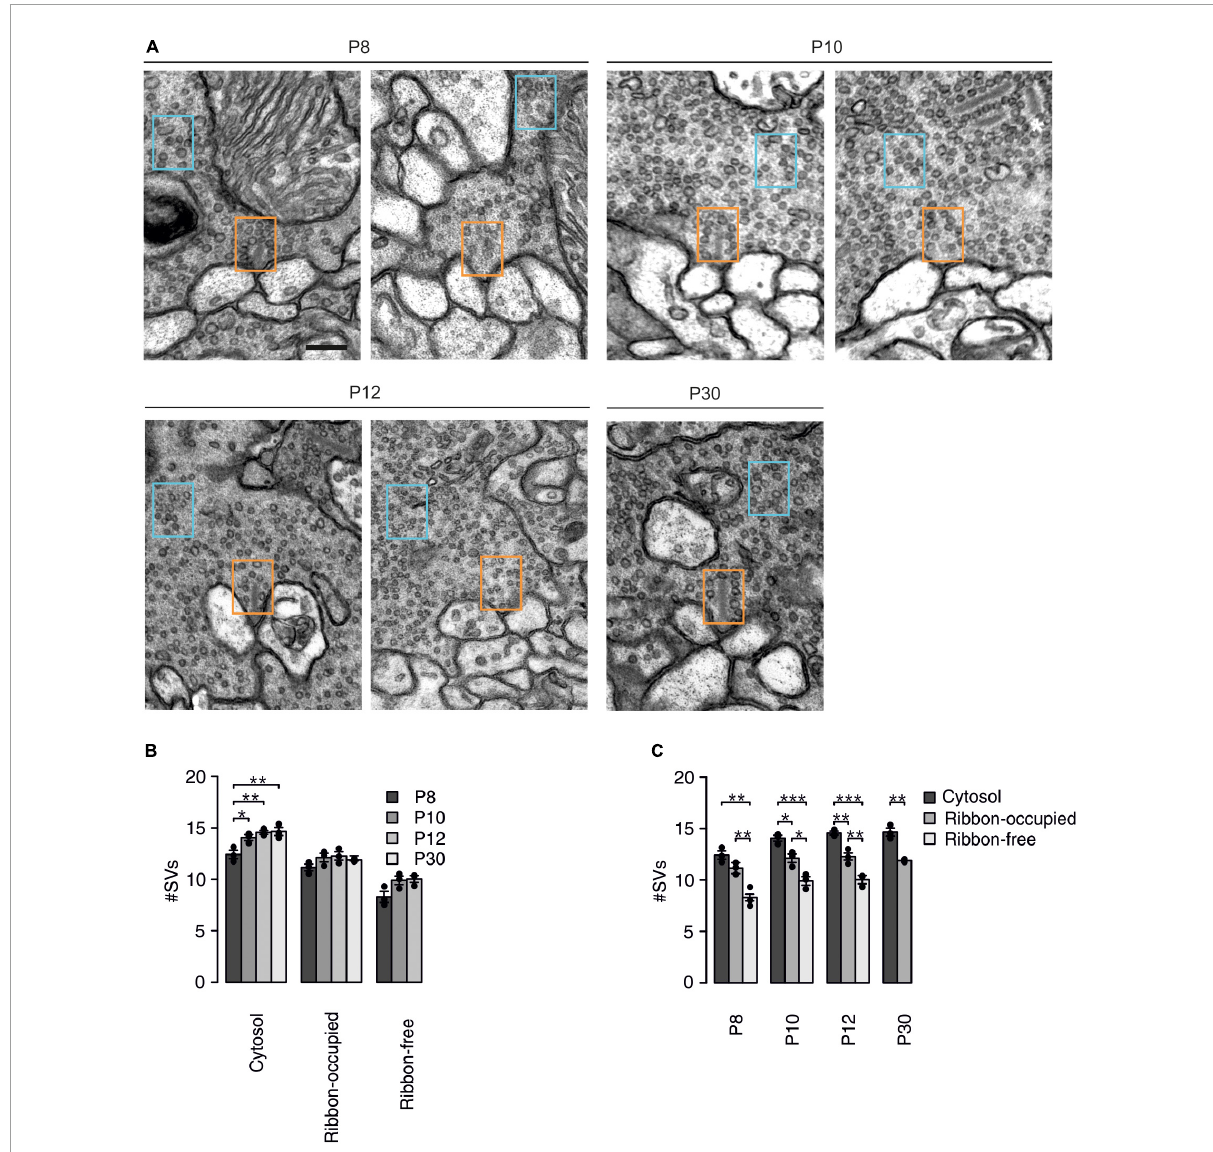
FIGURE4 Postnatal changes in SV density in cone photoreceptors synaptic terminals. (A) Representative electron micrographs of ribbon-occupied (left) and ribbon-free (right) AZs at mouse cone photoreceptor terminals at the different developmental stages. Number of SVs was quantified in a 300 × 200 nm region in the cytosol (blue box) and at an empty or ribbon-occupied AZ (orange box). Scale bar: 200 nm. (B) Number of SVs in a 300 × 200 nm region in different synaptic regions at the different developmental stages ( p < 0.001, n = 3 mice, two-way ANOVA). Post hoc pairwise Tukey tests of the cytosol group (P8 vs. P10: p = 0.033, P8 vs. P12: p = 0.008, P8 vs. P30: p = 0.006, P10 vs. P12: p = 0.718, P10 vs. P30: P = 0.603, P12 vs. P30: p = 0.997), ribbon-occupied AZ (P8 vs. P10: p = 0.258, P8 vs. P12: p = 0.164, P8 vs. P30: p = 0.457, P10 vs. P12: p = 0.986, P10 vs. P30: p = 0.963, P12 vs. P30: p = 0.848) and ribbon-free AZ (P8 vs. P10: p = 0.089, P8 vs. P12: p = 0.069, P10 vs. P12: p = 0.977). (C) Number of SVs in a 300 × 200 nm region in different synaptic regions at the different developmental stages (synaptic region: p < 0.001, n = 3 mice, two-way ANOVA). Post hoc pairwise Tukey tests of P8 group (ribbon-occupied AZ vs. ribbon-free AZ: p = 0.008, ribbon-occupied AZ vs. cytosol: p = 0.174: ribbon-free AZ vs. cytosol: p = 0.001), P10 group (ribbon-occupied AZ vs. ribbon-free AZ: p = 0.015, ribbon-occupied AZ vs. cytosol: p = 0.026: ribbon-free AZ vs. cytosol: p < 0.001), P12 group (ribbon-occupied AZ vs. ribbon-free AZ: p = 0.007, ribbon-occupied AZ vs. cytosol: p = 0.006: ribbon-free AZ vs. cytosol: p < 0.001) and P30 group (ribbon-occupied AZ vs. cytosol: p =